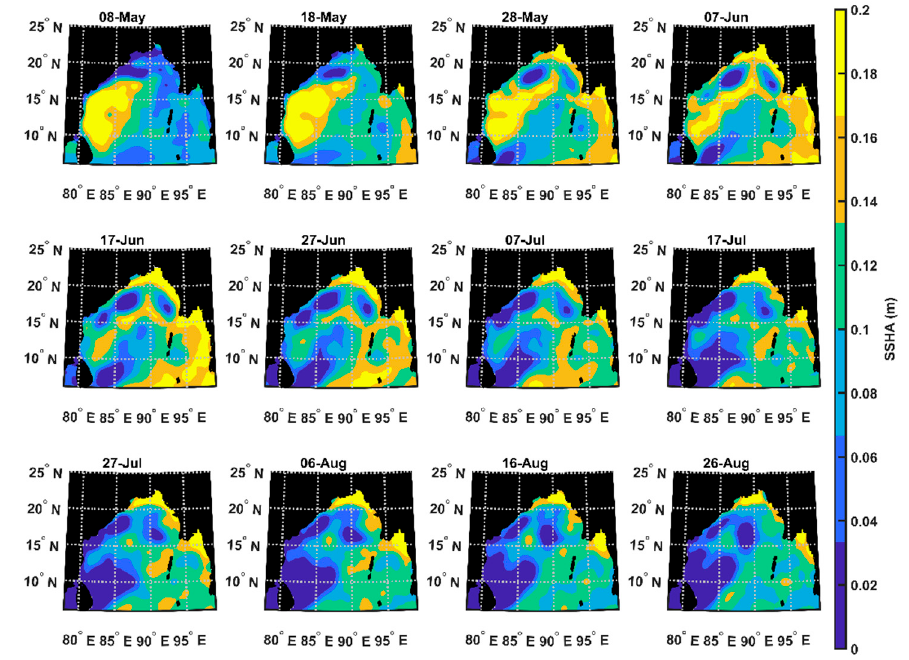
Figure 8. Decadal Climatology (2009 to 2018) of negative SSHA corresponding to the 1st downwelling Kelvin wave activity.